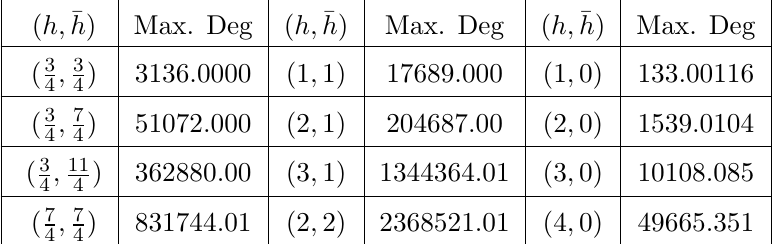
Table 7. The maximum value of degeneracies for low-lying states in a putative CFT with c = 7.